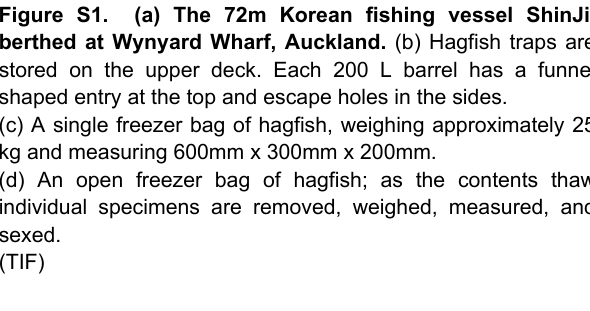
(a) The 72m Korean fishing vessel ShinJi, berthed at Wynyard Wharf, Auckland. (b) Hagfish traps are stored on the upper deck. Each 200 L barrel has a funnel shaped entry at the top and escape holes in the sides. (c) A single freezer bag of hagfish, weighing approximately 25 kg and measuring 600mm x 300mm x 200mm. (d) An open freezer bag of hagfish; as the contents thaw individual specimens are removed, weighed, measured, and sexed.